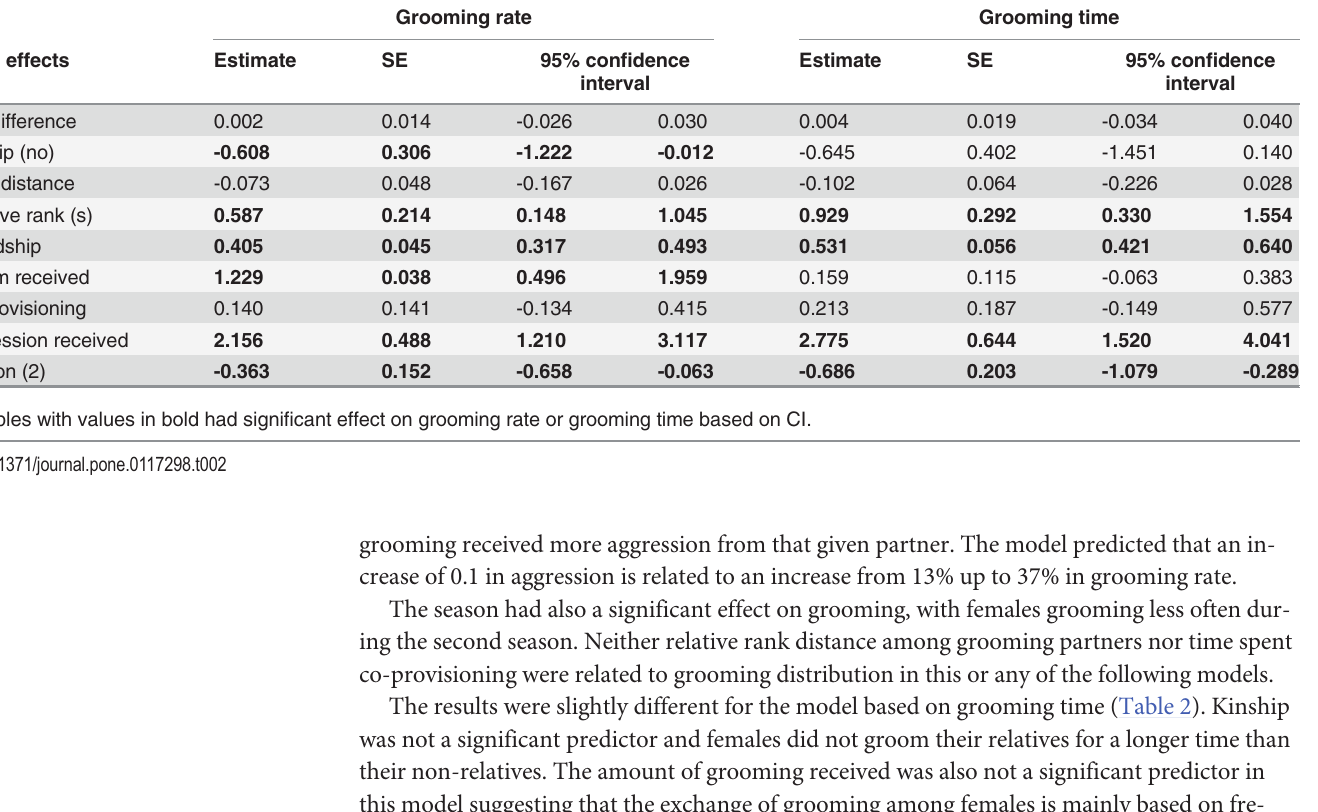
Table 2. Results of LMMs testing grooming rate and grooming time and their relationship to kinship, rank distance, relative rank, friendship, grooming received, co-provisioning, aggression received and season. Grooming rate Grooming time